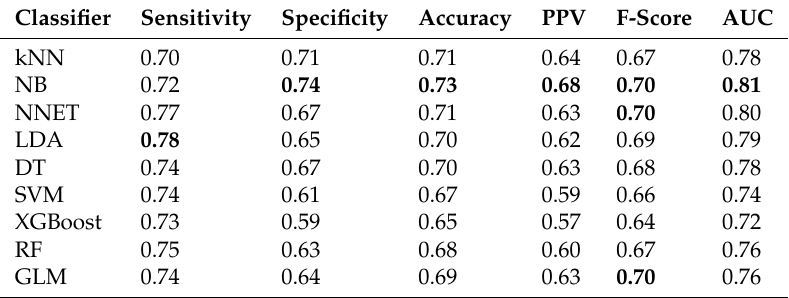
Table 5. Predictive performance of machine learning and generalised linear models based on the estimated sensitivity, specificity, accuracy, positive predictive value (PPV), F-score and the area under receiver operating characteristic curve (AUC) using leave-out-one-animal approach to validation studies for combined data.